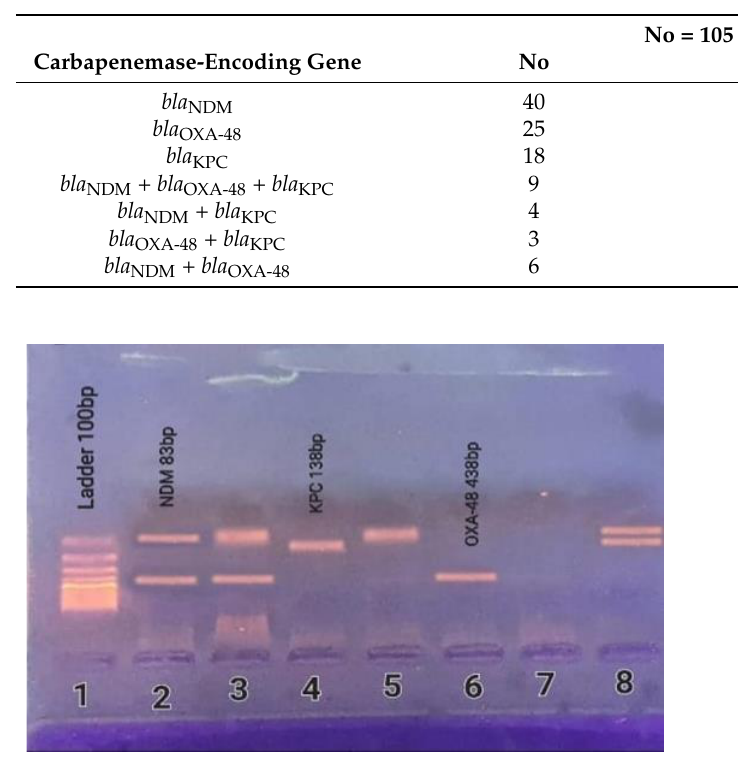
Figure 2. PCR results for carbapenemase-encoding genes; lane ( 1 ): DNA ladder 100 bp, lanes ( 2,3 ):